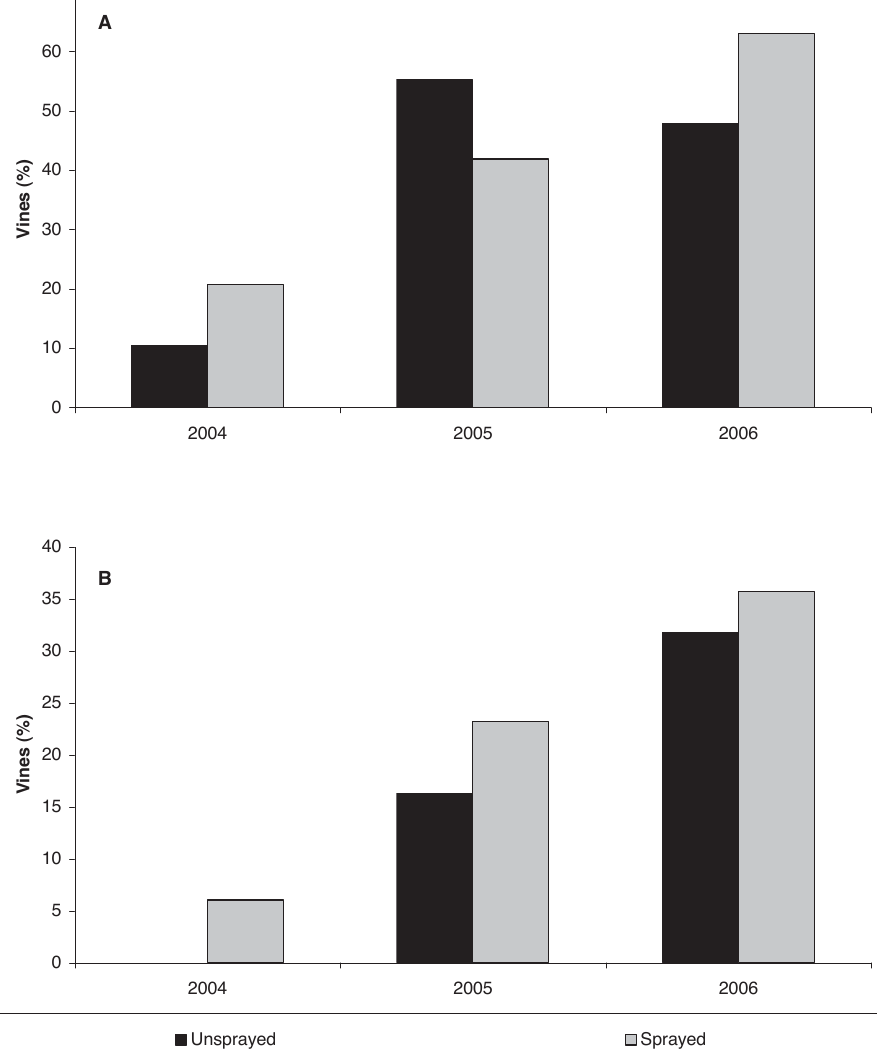
Fig. 3. Effects of applications of Kendal on the frequency of symptomatic vines that showed symptoms in previous years assessed in vineyards cv. Albana (A) and Sangiovese (B). For each treatment and year of assessment, values of frequency are not signi fi cantly different according to Chi–Square test ( P